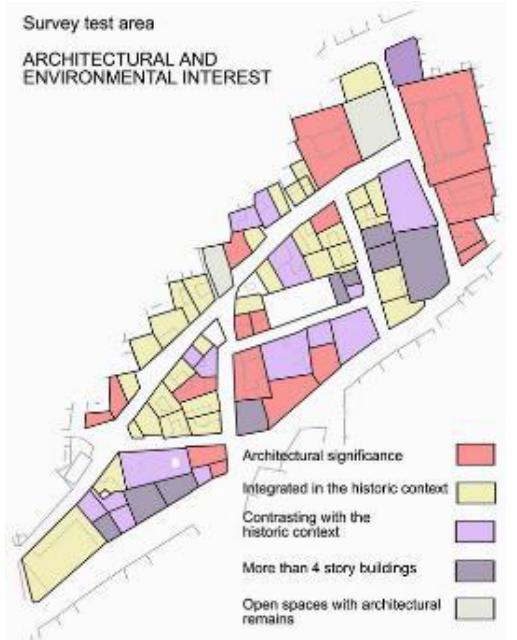
Figure 5. 1The survey test area in the “transitional” zone (Agriculture,